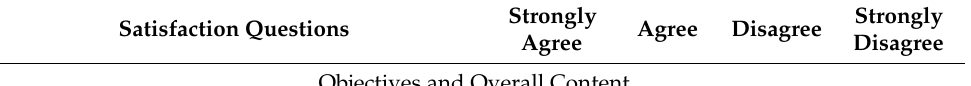
Table A2. Satisfaction